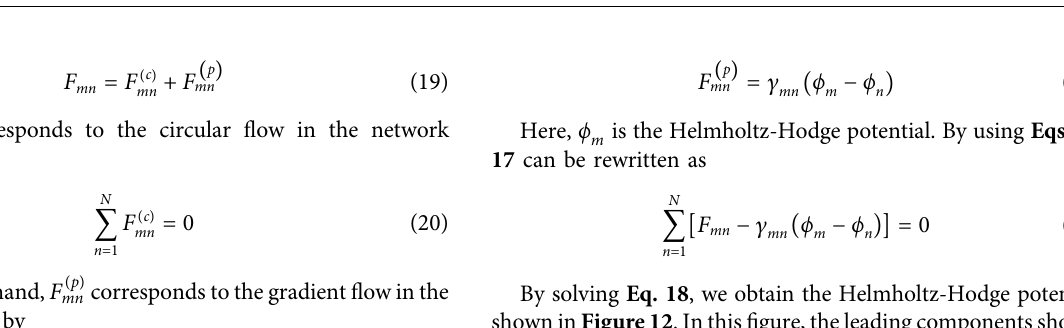
FIGURE 7 | (Upper left) Distribution of the elements ~ C mn of the complex correlation matrix ~ C in the complex plane [ R ( ~ C mn ) , I ( ~ C mn )] . (Upper right) Distribution p [ I ( ~ C mn )] oftheelementsoftheimaginalpart I ( ~ C mn ) ofthecomplexcorrelationmatrix. (Lowerleft) Distribution p [ R ( ~ C mn )] oftheelementsoftherealpart R ( ~ C mn ) of the complex correlation